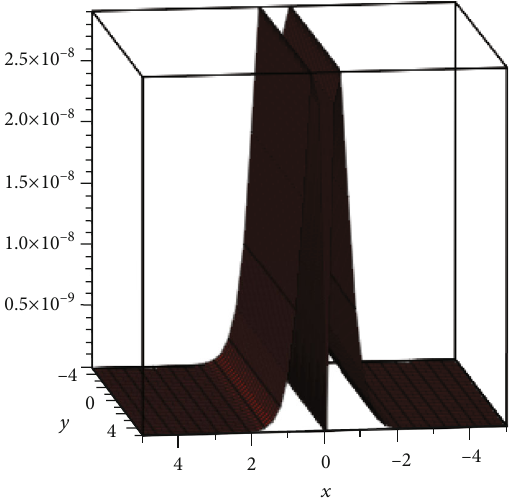
Figure 4: Graphical view of the absolute error for J ð ζ , ρ Þ of system 1